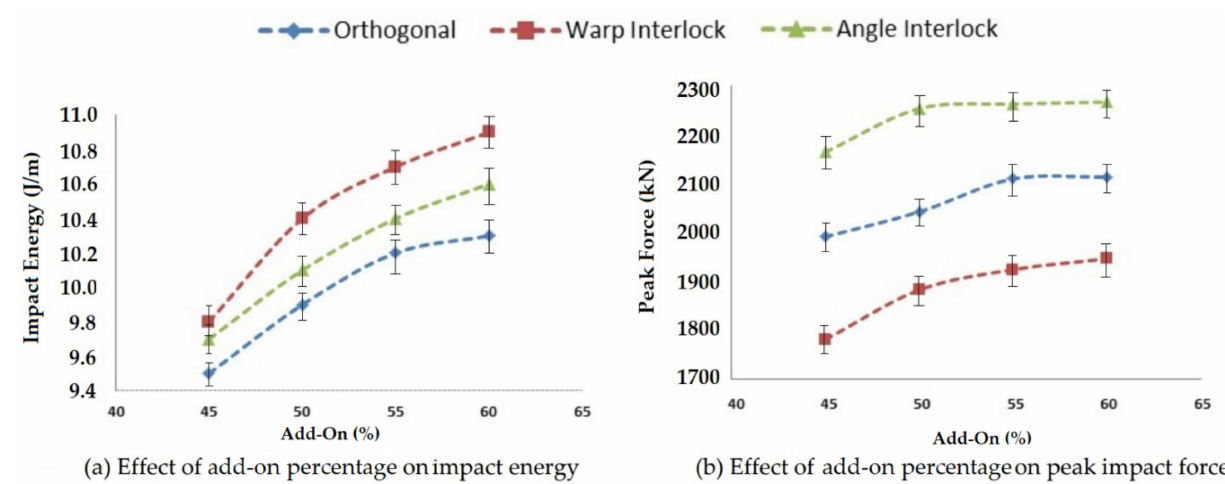
Figure 12. Effect of add-on percentage on the impact properties of 3D woven